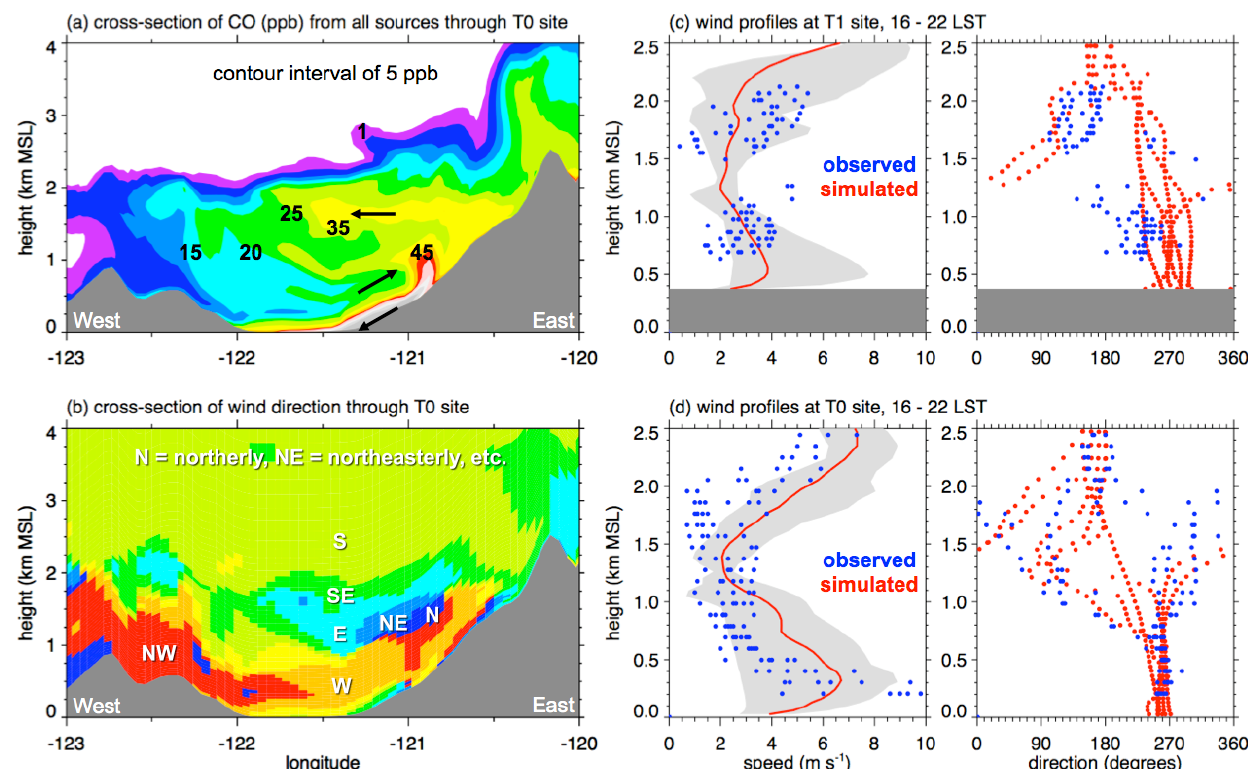
Figure 17. West-east vertical cross sections through the T0 site at 22 LST for (a) CO from all anthropogenic sources and (b) simulated wind direction (denoted by N, NE, E, SE, S, SW, W, and NW). Observed radar wind profiler (blue) and simulated (red) wind speed and direction profiles at the (c) T1 and (d) T0 sites between 17 and 23 PDT, 22 June. Dark gray shading denotes terrain height and light gray shading in (c) and (d) denote range of simulated values.